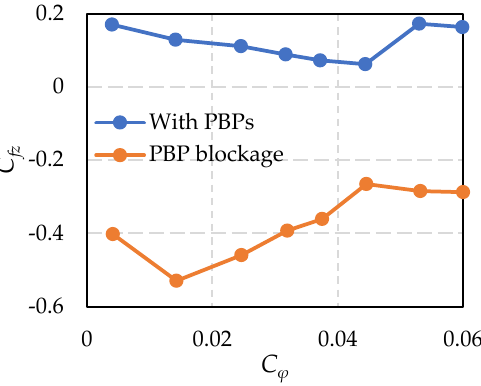
Figure 11. Comparison of runner axial force with and without the PBPs.